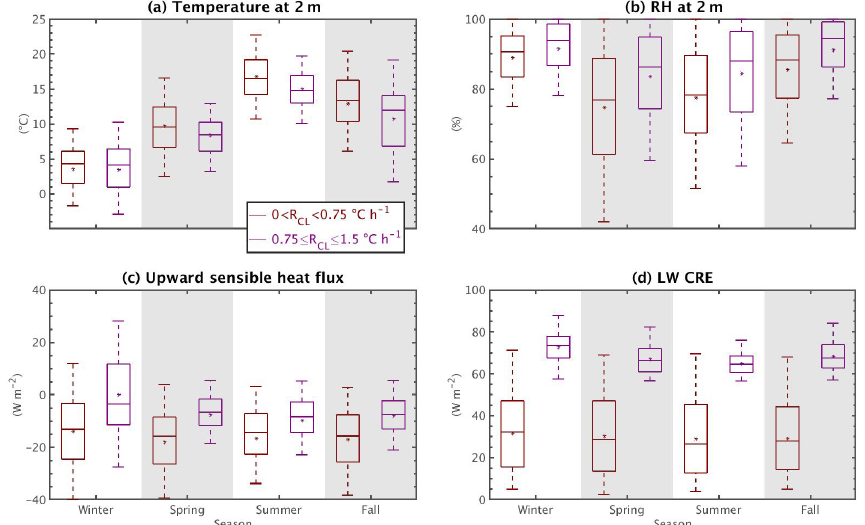
Figure 11. Nighttime values for (a) temperature, (b) relative humidity, (c) upward sensible heat flux at 2m, and (d) longwave cloud radiative effect. Colors and boxplots follow the same definition as in Fig.